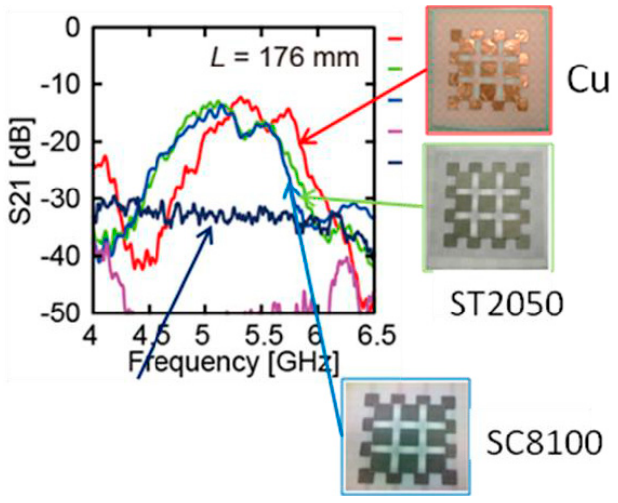
Figure 7. Transmission characteristics of the two-dimensional transmission line with a conductive cloth.